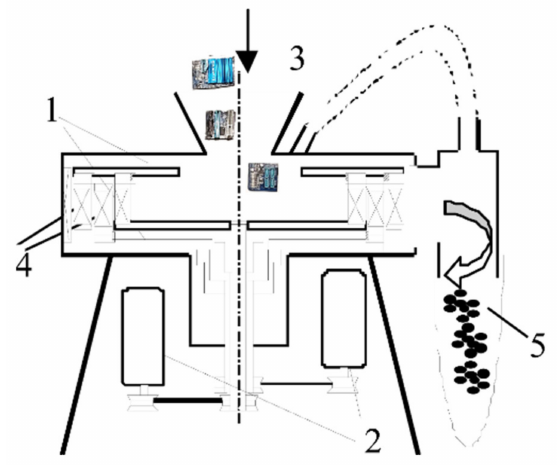
Figure 2. Schematic representation of preliminary size reduction centrifugal-type mill DSL-350. Equipment: 1—rotors; 2—electric drives; 3—material (PCBs) supply; 4—horizontally oriented grind- ing elements; 5—output.